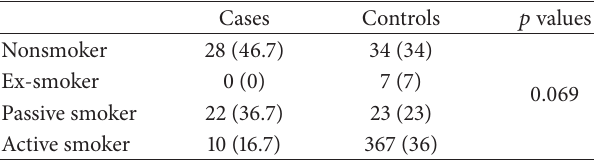
Table 3: Smoking status in cases and controls.